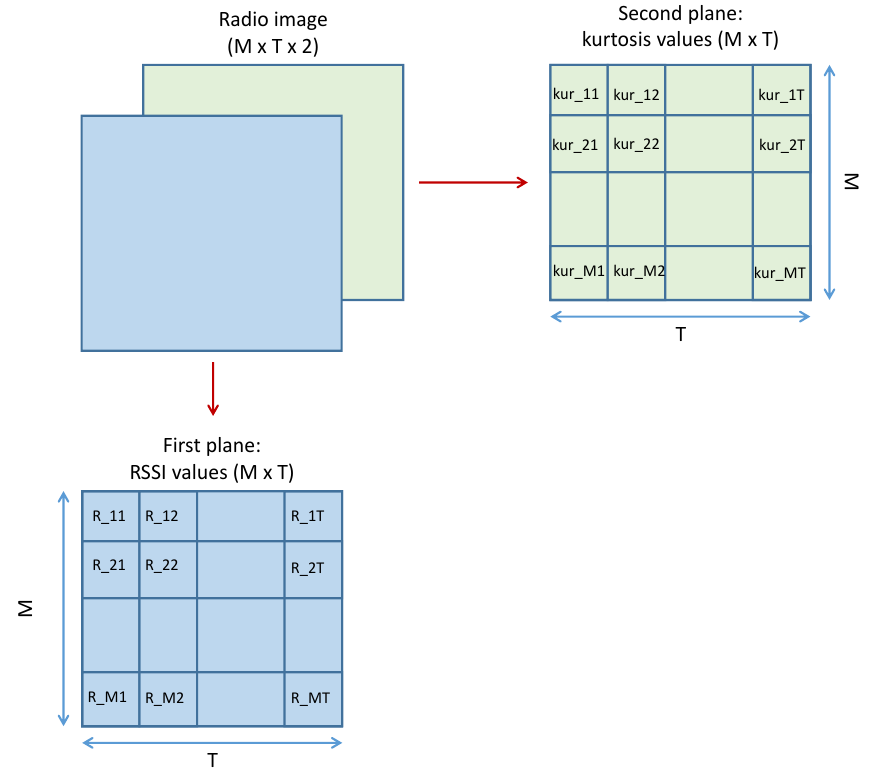
Figure 4. The structure of the radio